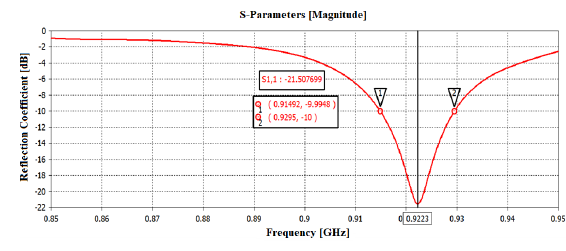
Fig. 2. Reflection coefficient (S11) results.